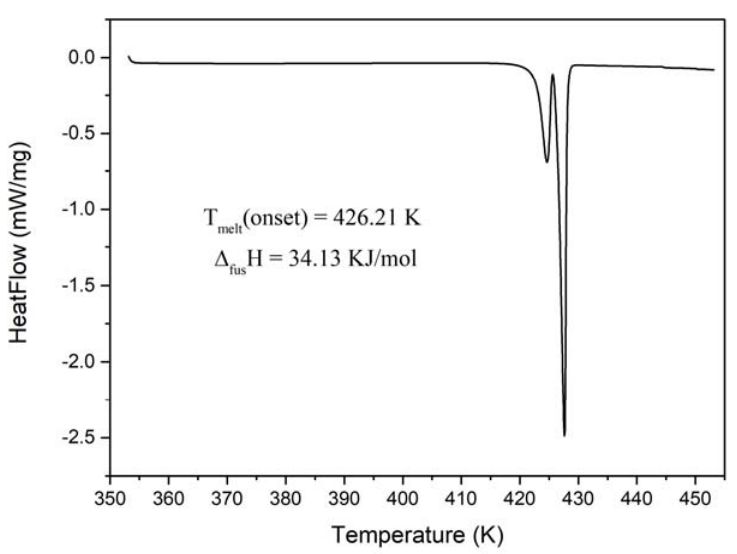
Figure 3. Thermal analysis spectrum (DSC) of florfenicol.